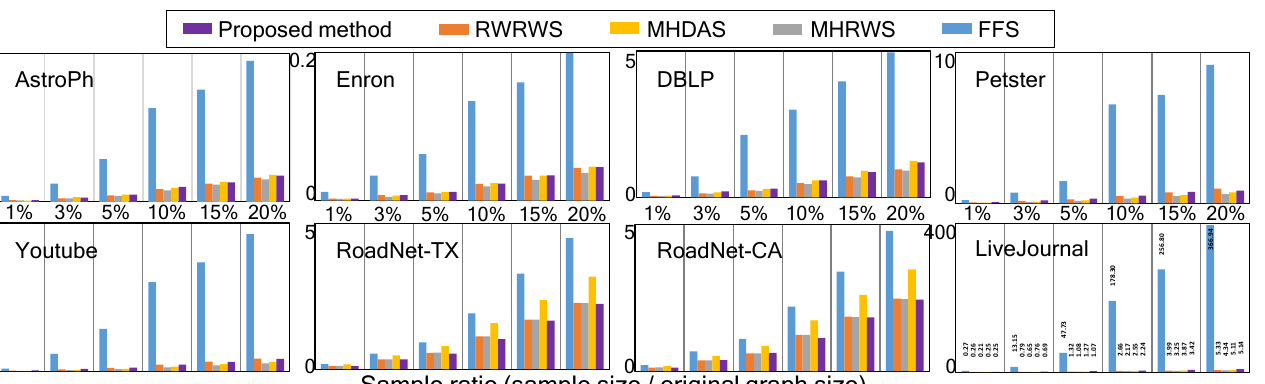
The sequential version of the proposed network sampling method has a time com- plexity of O ( | s | ) and space complexity of O ( | s | + | w | ) , where | s | and | w | are the size of the sample and its weight vector, respectively. As shown in Figure 9, the time costs of the sequential version of the proposed method are moderate, even for large network databases obtained from real applications. The run time is shown as the average of the time of 2000 independent sampling tests on each network database.